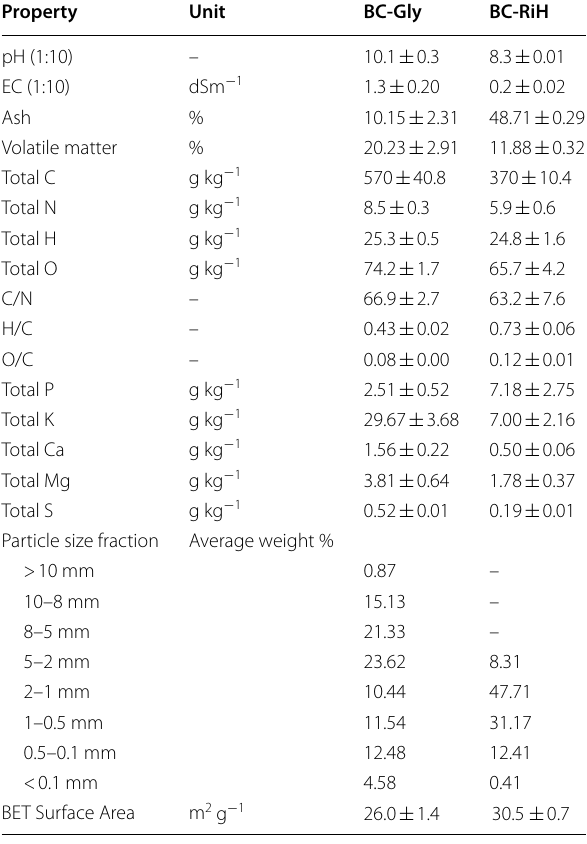
Table 2 Properties of used Biochar (means n 3; for surface area n = and volatile matter expressed on a dry weight basis